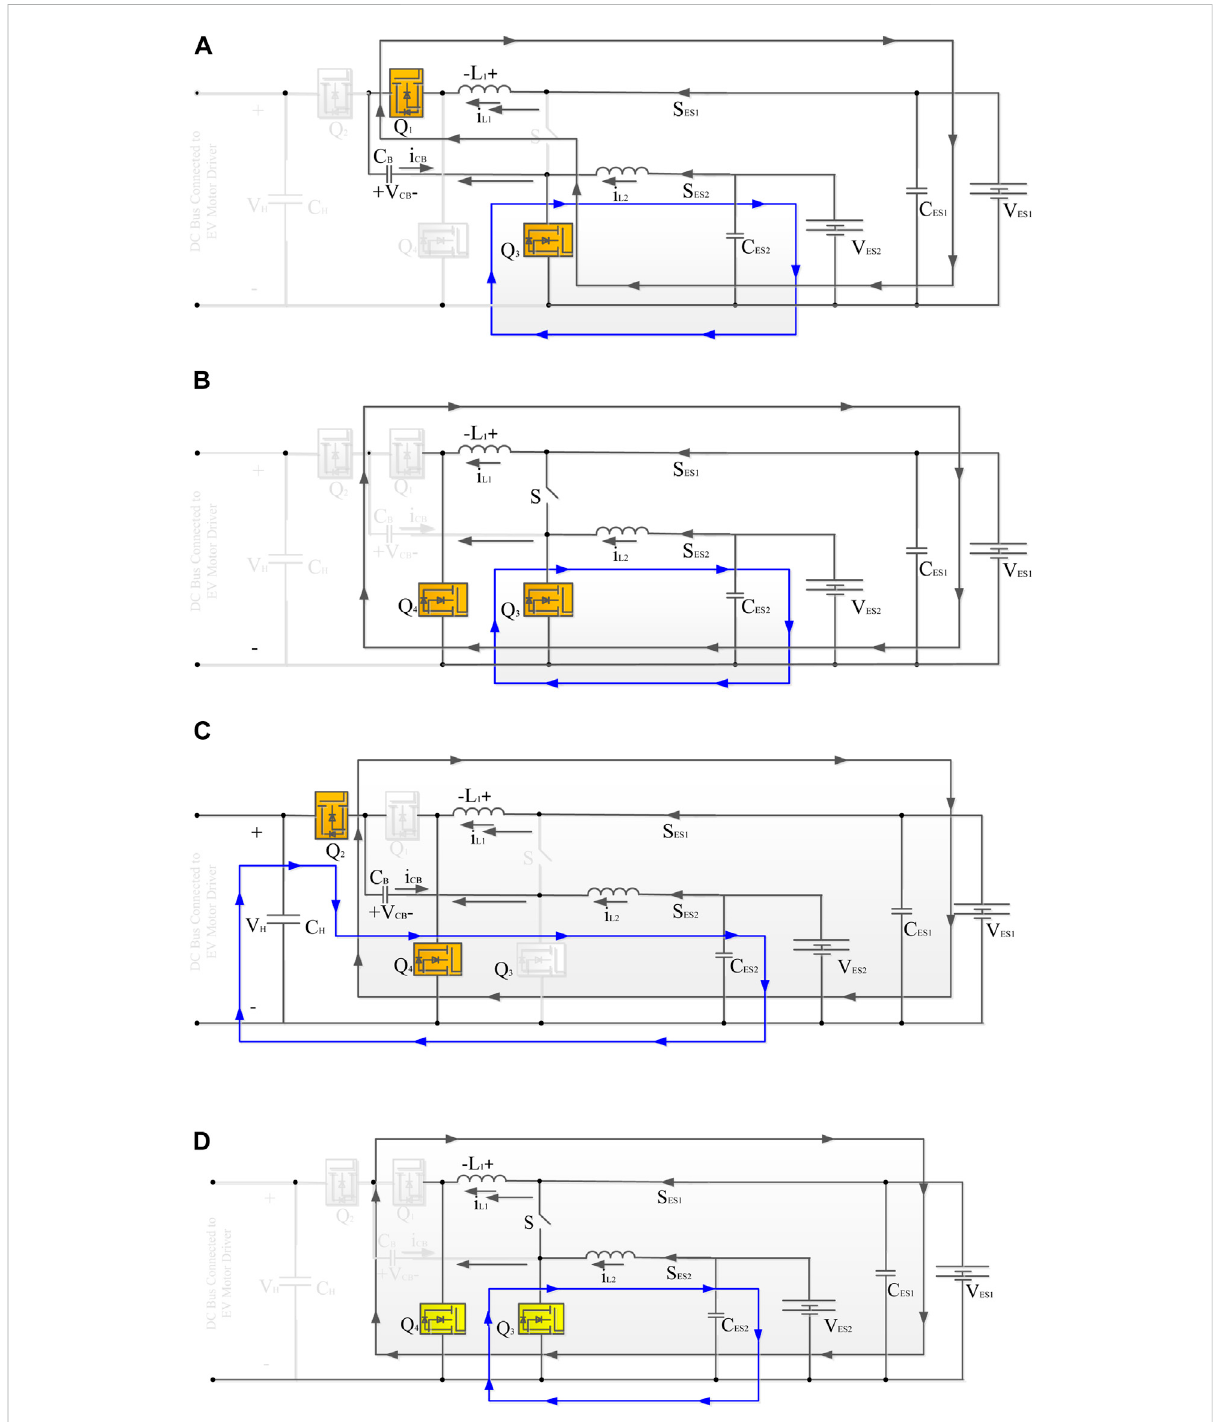
FIGURE 6 The proposed BDCC ’ s circuit states for the energy-regenerating high-voltage dc-link levels: (A) Level 1 (B) Level 2 (C) Level 3 (D) Level